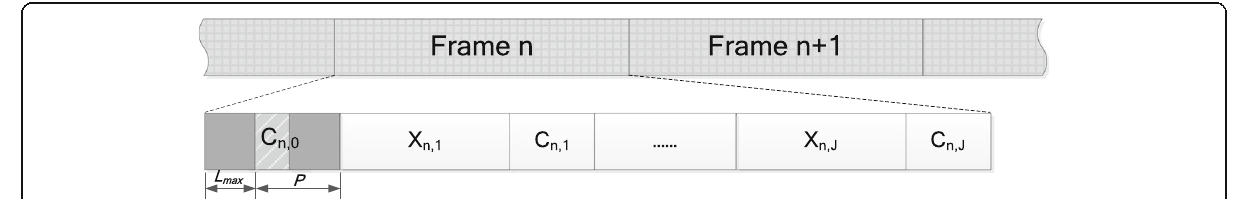
Fig. 2 The frame structure of SC-FDE for PIA